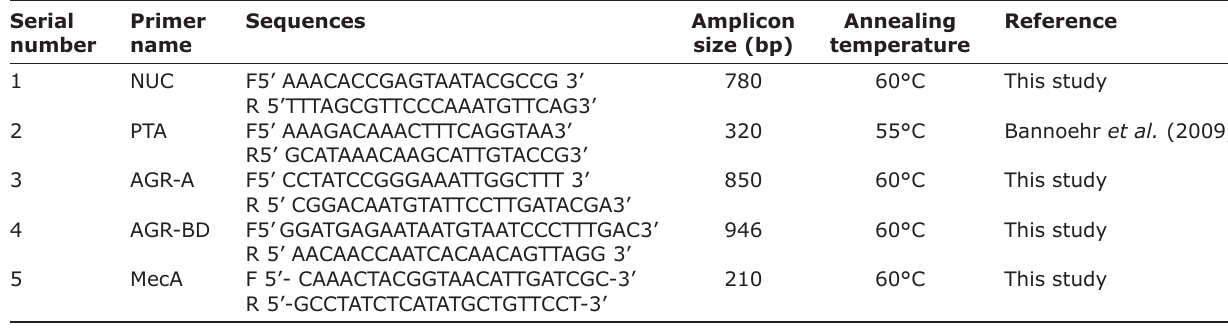
Table-1: Primers used in this study along with amplicon size, annealing temperature, and references. Serial